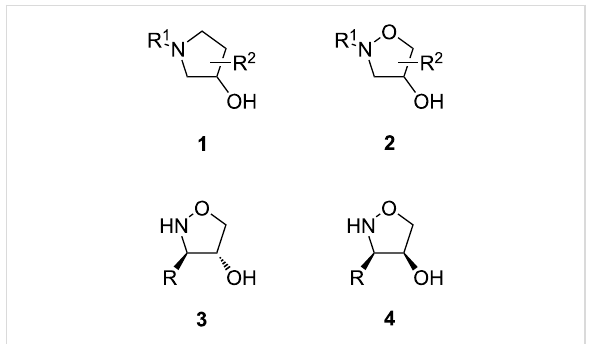
Figure 1: 3-Substituted isoxazolidin-4-ols resembling 3-hydroxypyrro-